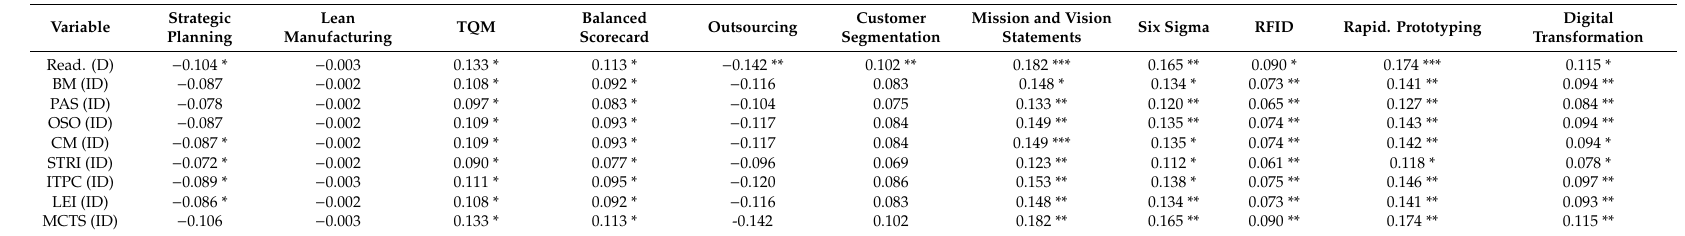
Table 3. Standardized direct and indirect e ff ects among